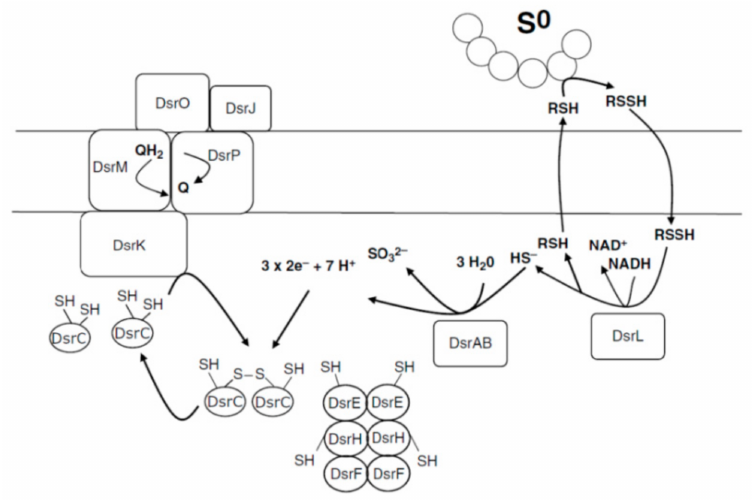
Figure 4. Schematic distribution of Dsr proteins in the Allochromatium vinosum cell. This scheme is based on sequence analysis of dsr coding genes and on available biochemical information (data from Dahl, 2008